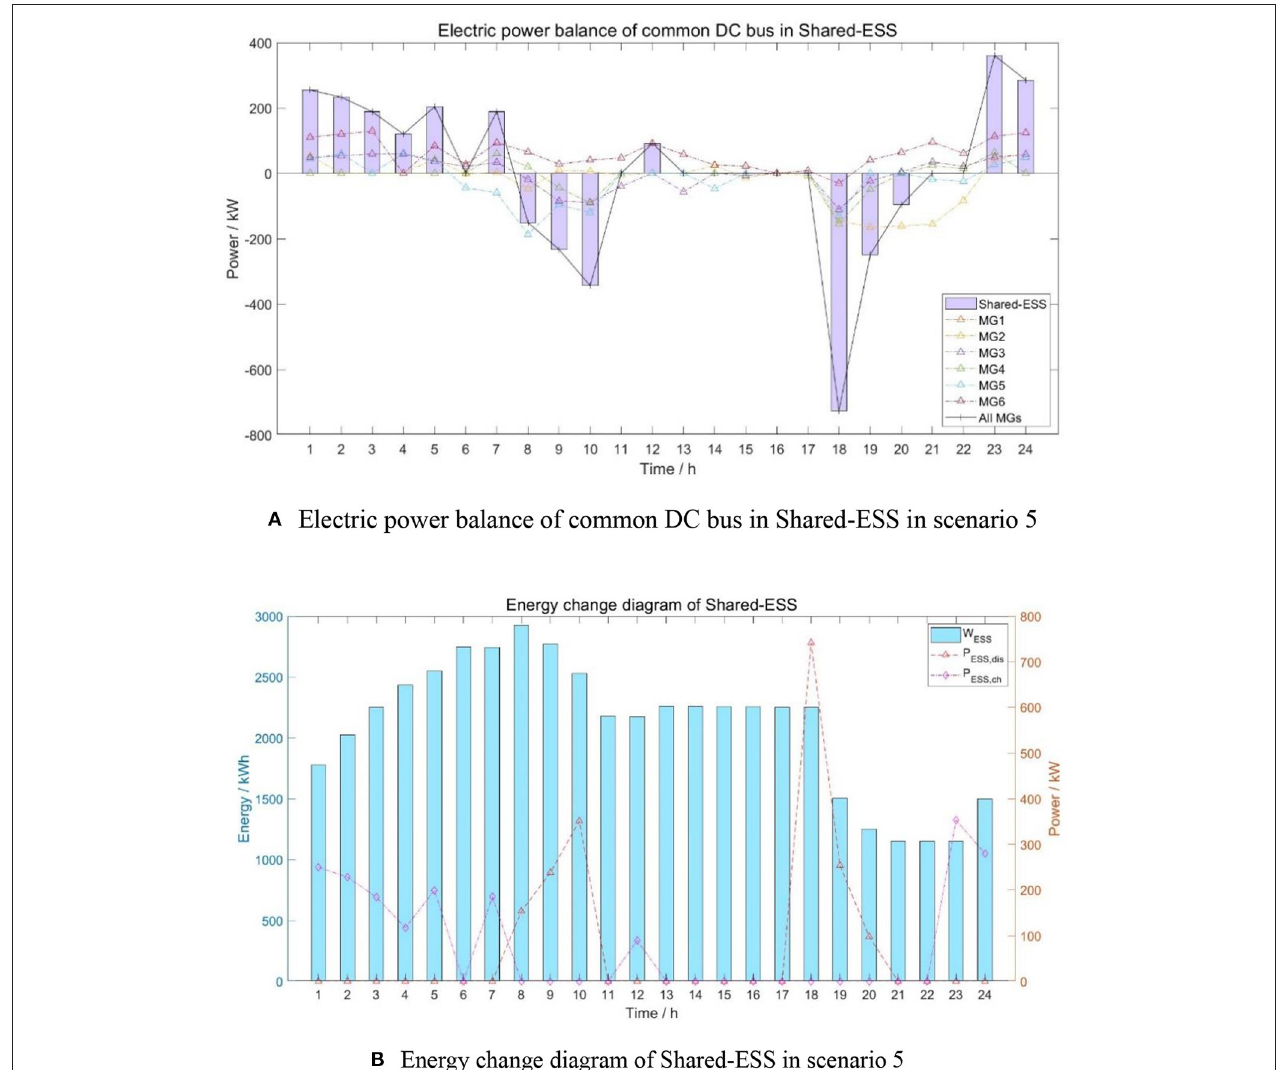
FIGURE 9 | The operating status of Shared-ESS in scenario 5. (A) Electric power balance of common DC bus in Shared-ESS in scenario 5. (B) Energy change diagram of Shared-ESS in scenario